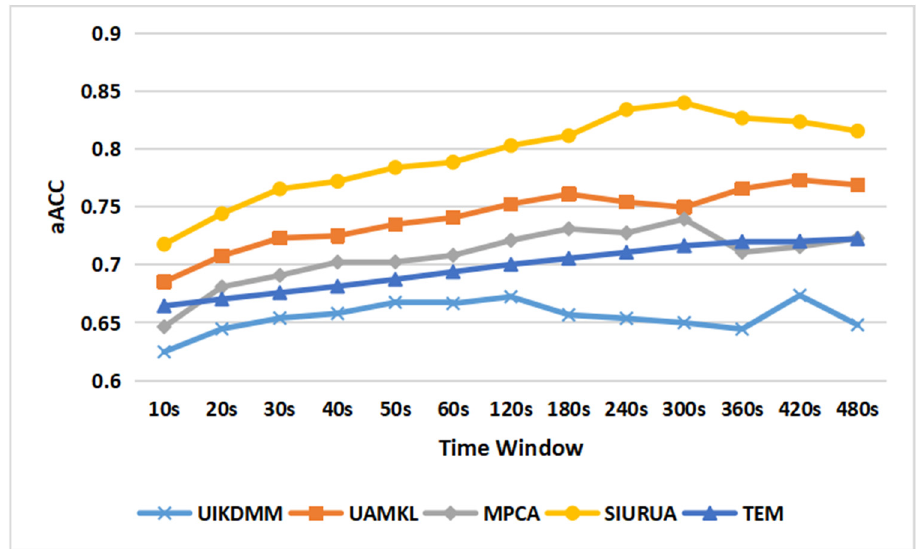
Figure 13. Comparison of accuracy between SIURUA and the proposed user authentication method.